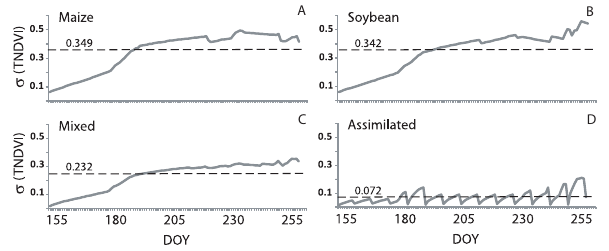
Fig. 4. Temporal dynamics of propagated errors from EDPM sim- ulations (A) maize; (B) soybean, (C) mixed crop and in the onedi- mensional Kalman Filter (1DKF) assimilation scheme (D) for 2005 growing season in Bondville. Dashed lines are the seasonal aver- ages of daily propagated errors shown as solid grey